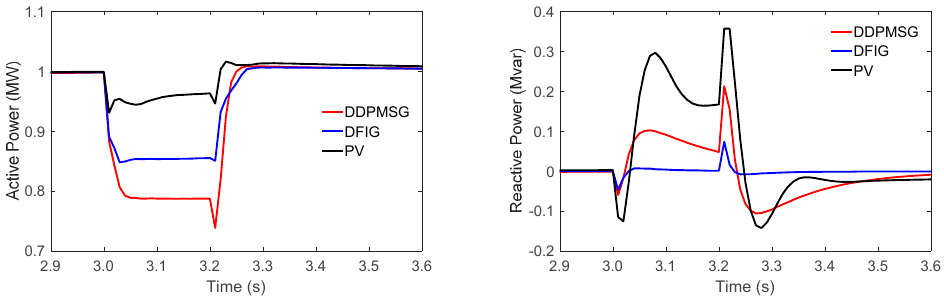
Figure 2. Dynamic responses of three types of DGs.